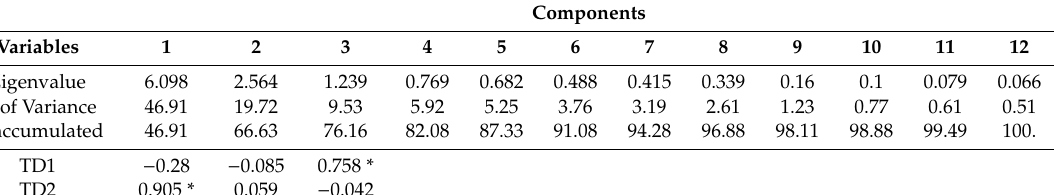
Table 3. Component analysis values.